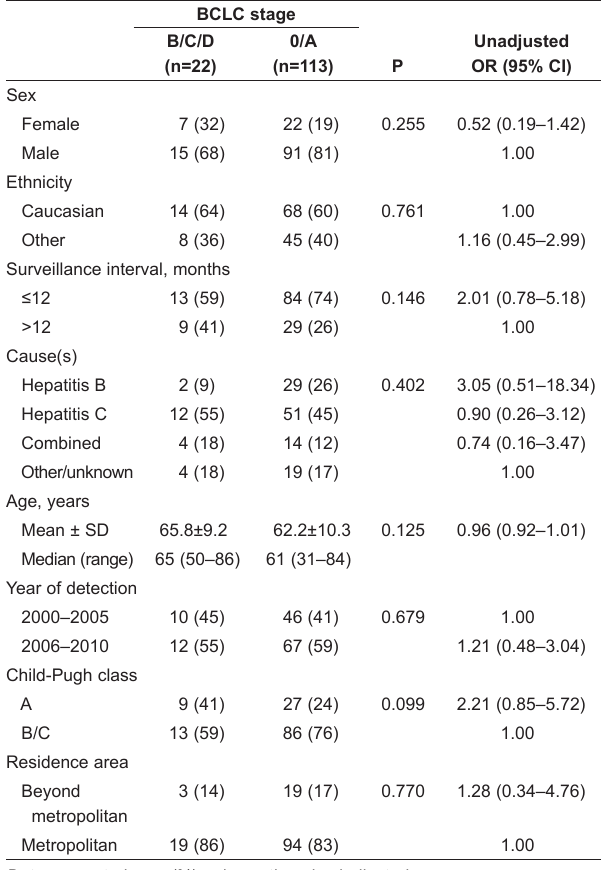
TABlE 4 Serum alpha-fetoprotein (AFP) levels in hepatocellular carcinomas within and outside Milan criteria for liver transplantation